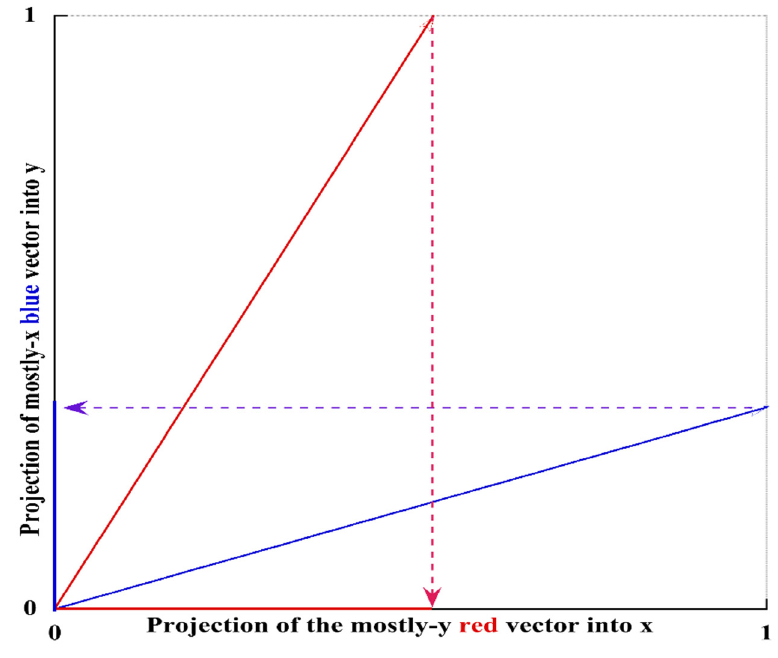
Figure 8. The blue and red lines are representational data vectors separated by a 44° angle in their multi-dimensional phase space. The dotted arrows indicate that each vector has a projection onto both the x-axis and the y-axis. Explanatory ambiguity results from the fact that each SEQ facet vector is an admixture of each of the unique meanings represented by each of the orthogonal axes. However, the unique meanings themselves remain unknown, as does the dimensionality of the SH phase space.